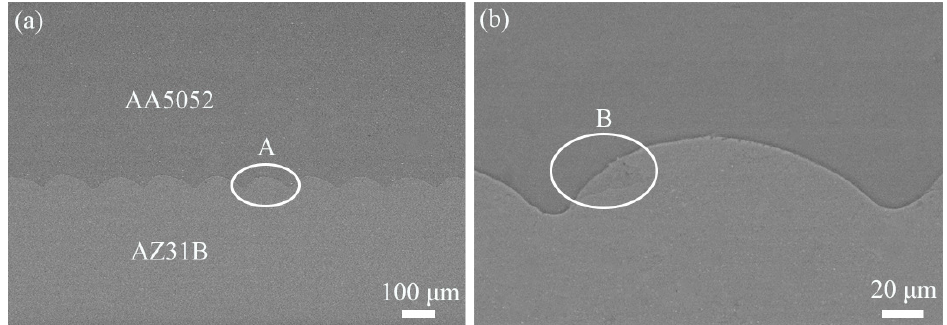
Figure 6. SEM image of AA5052/AZ31B bonding interface, ( a ) typical wave, ( b ) high-resolution image of position A in ( a ).